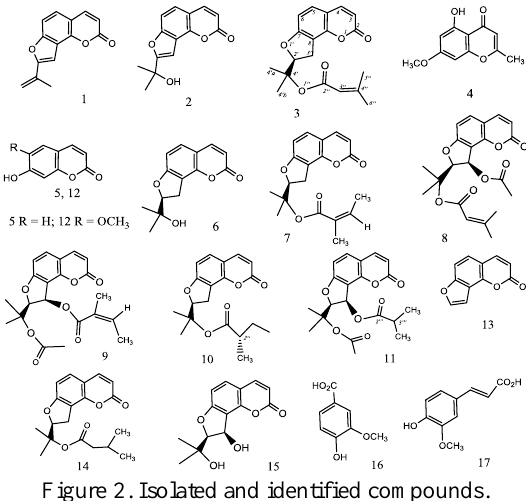
Figure 2. Isolated and identified compounds.